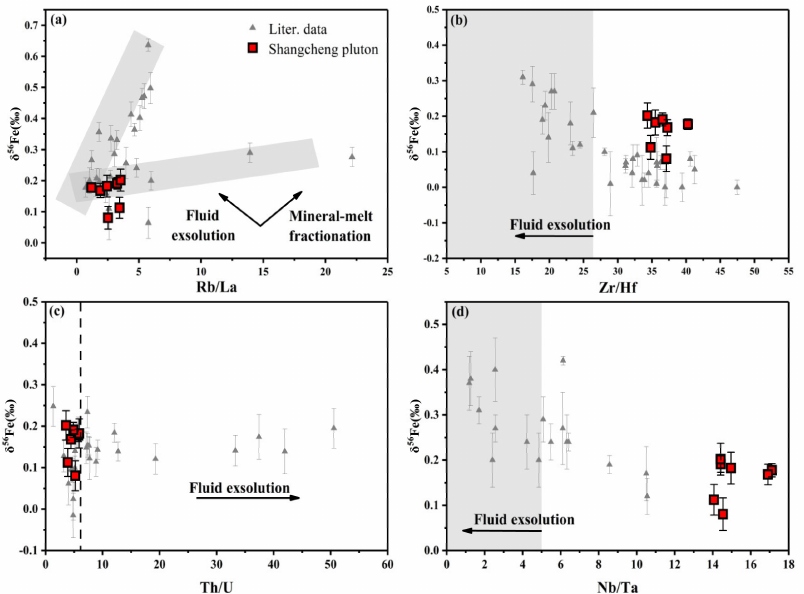
Figure 8. ( a ) Rb/La vs. δ 56 Fe, ( b ) Zr/Hf vs. δ 56 Fe, ( c ) Th/U vs. δ 56 Fe, ( d ) Nb/Ta vs. δ 56 Fe. Data were taken from